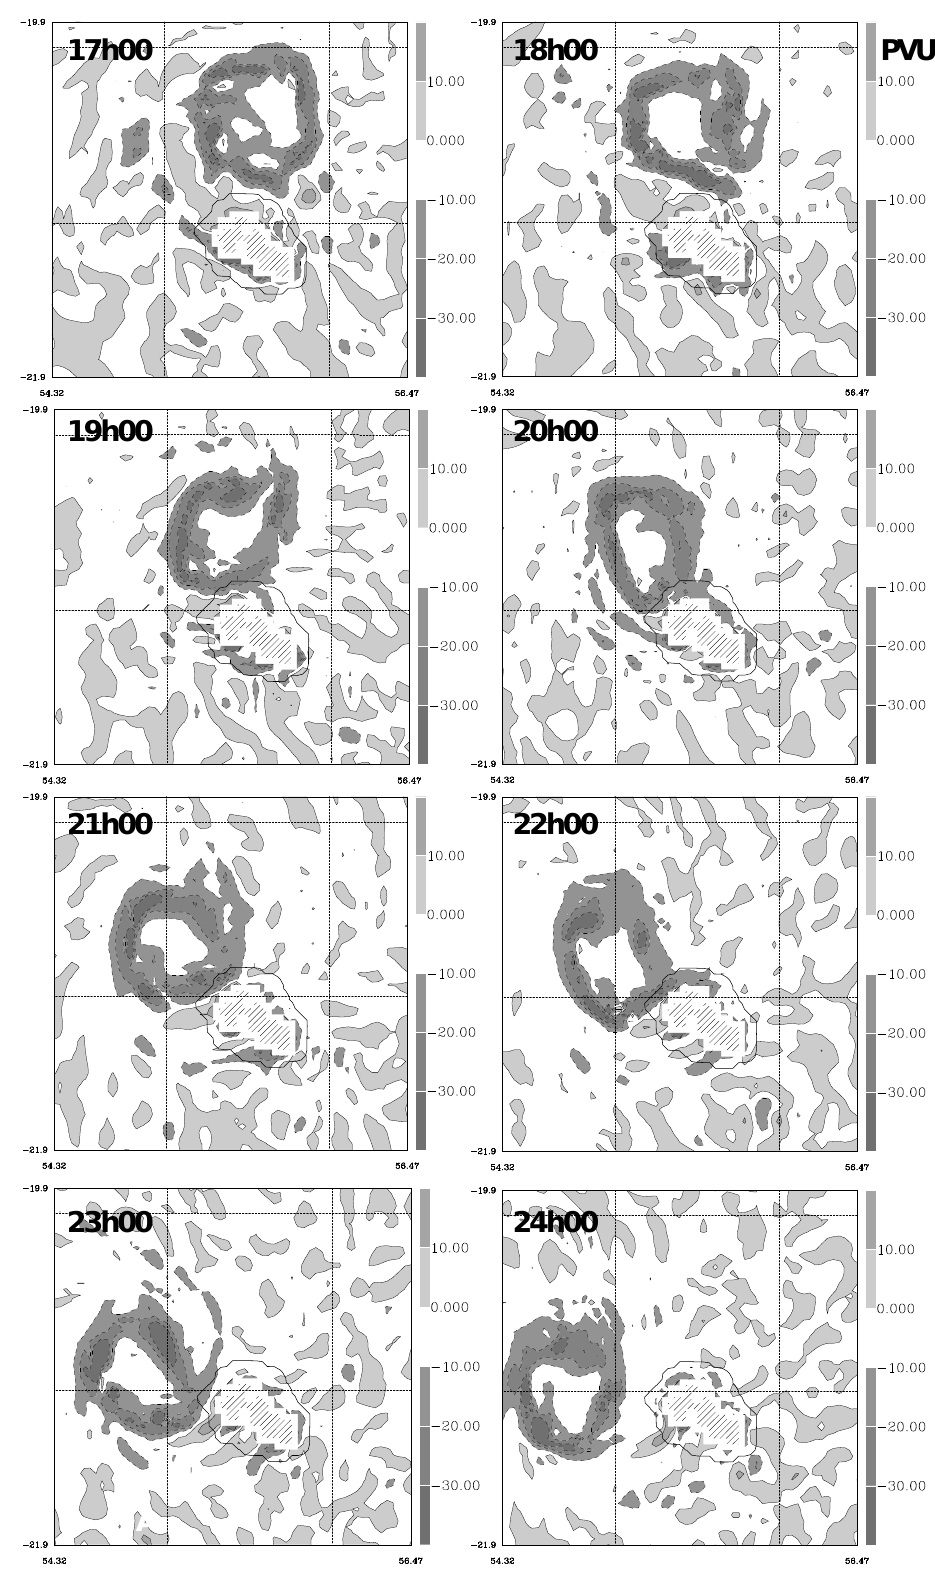
Fig. 14. Potential vorticity fields (shaded, PVU = 10 − 6 m 2 s − 1 Kkg − 1 ) from the 4-km model of the “ Island ” experiment at 1000m altitude, every hour from 17 to